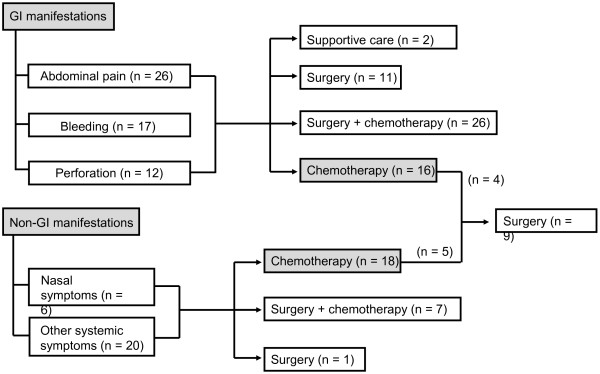
Summary of treatment approaches.